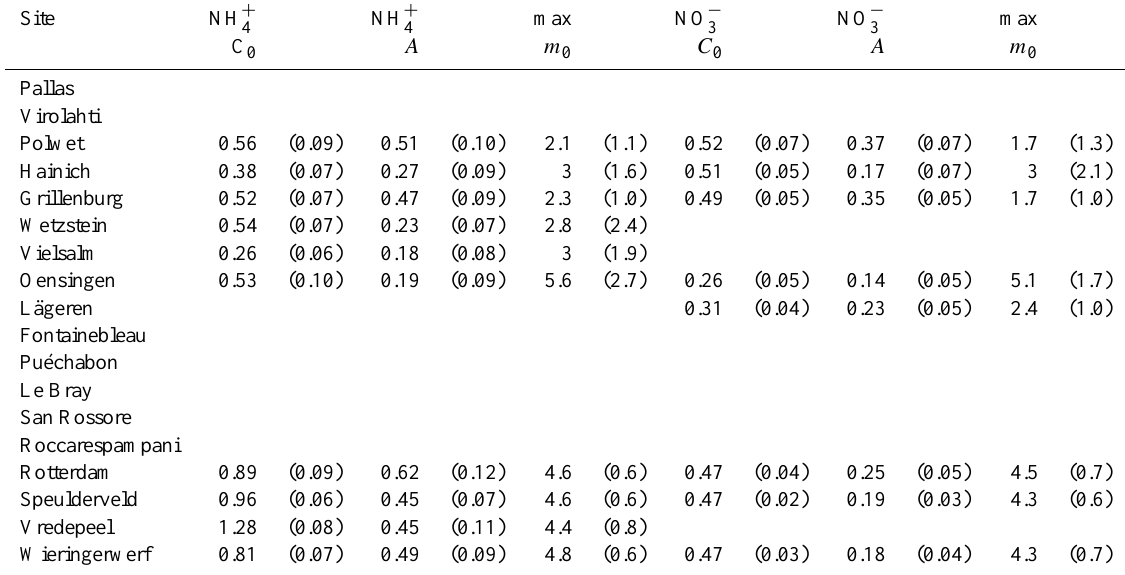
Table 3. Seasonal variations in ammonium and nitrate concentrations (mgNl − 1 ) from non-linear fitting of a sine function to monthly data, where C(m) = C 0 + A. sin (π/ 6 .(m − m 0 + 3 )) , and C 0 , A and m 0 are fitted parameters for the annual mean, seasonal amplitude and month of maximum amplitude, respectively. Data are shown only for sites where the probability of A> 0 exceeds 95%. Standard errors of fitted parameters are shown in parentheses.